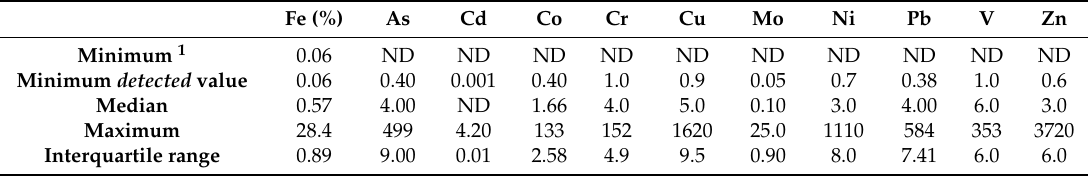
Table 3. Minimum, minimum detected , median, maximum, and the interquartile range of concentrations for iron and trace metals in Paleozoic whole-rock samples from northeastern Wisconsin. For Fe, the unit is percentage, while all other elements are measured in mg/kg (ppm). Reported values are for all samples in the study (matrix and enriched, n = 310). ND is a value below the detection limit for that respective element.